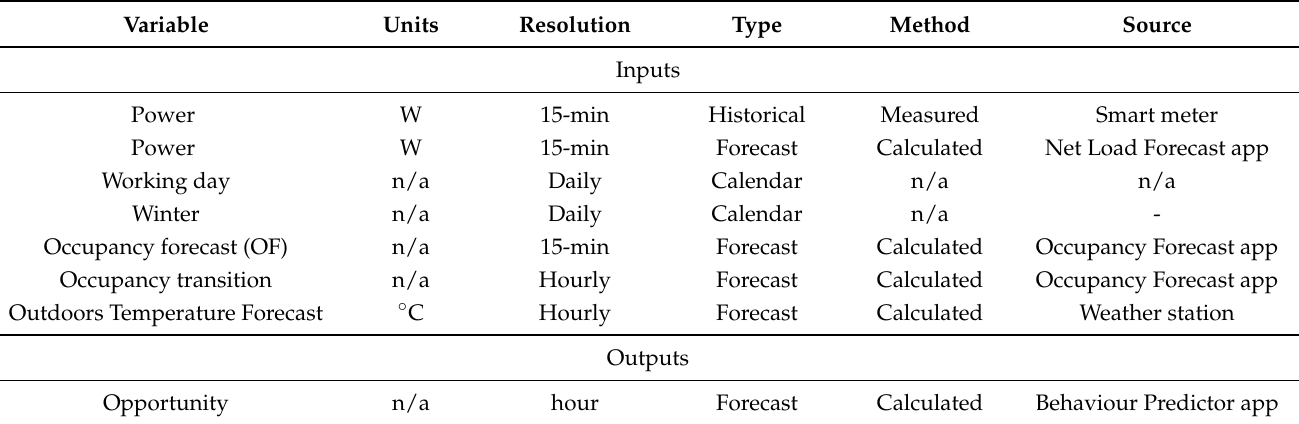
Table 16. Detailed list of inputs and outputs for Behaviour Predictor